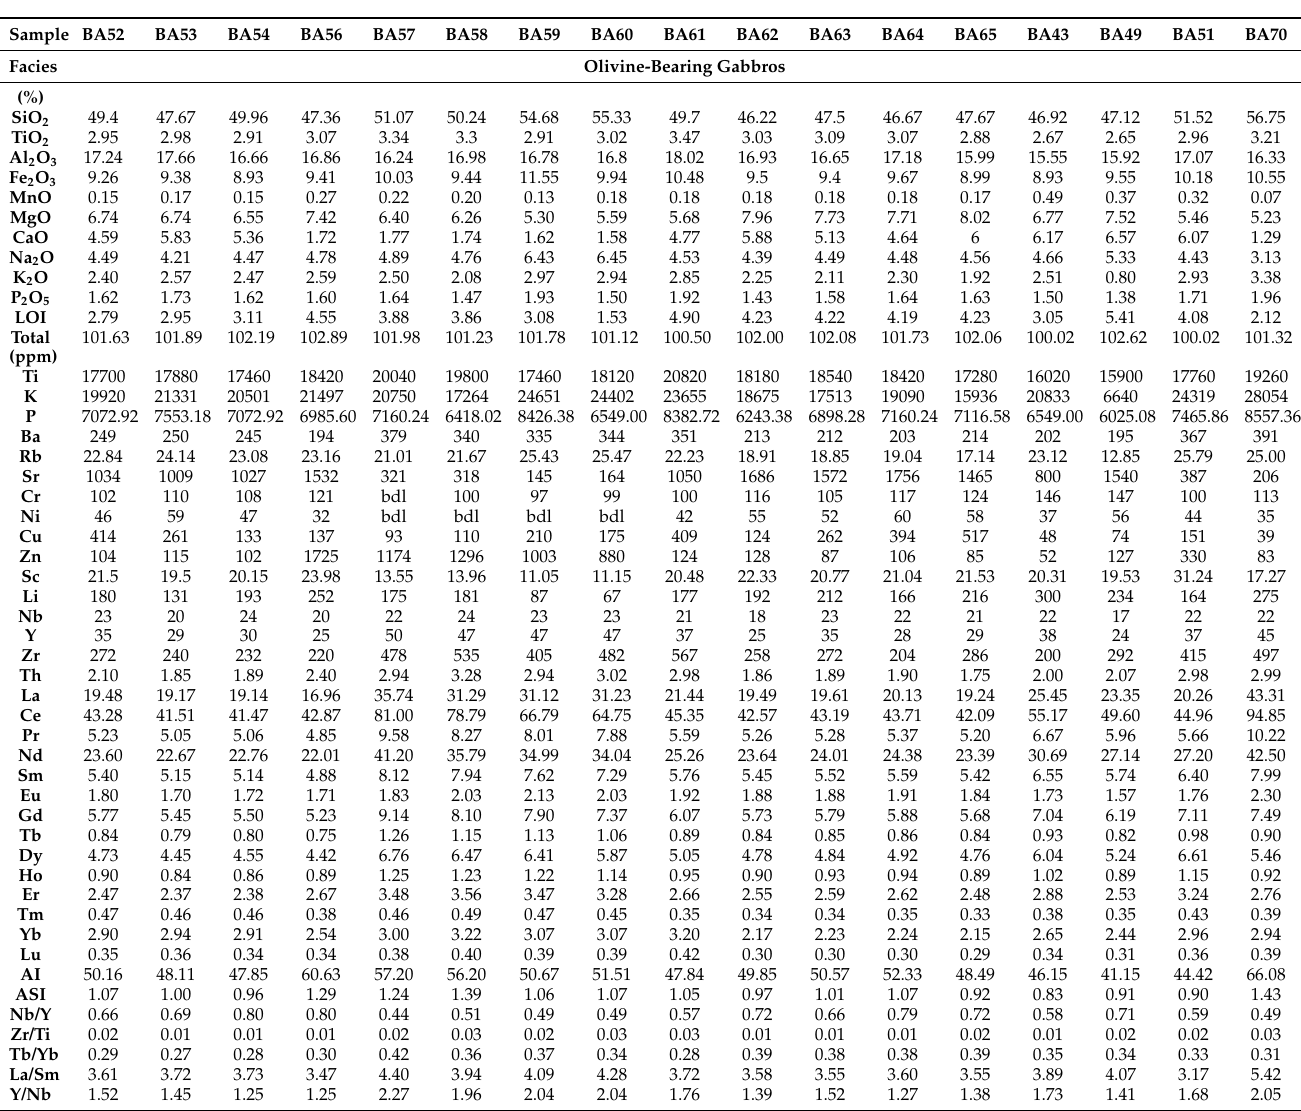
Table 3. Chemical analyses of the major, trace and rare earth elements of the olivine-bearing